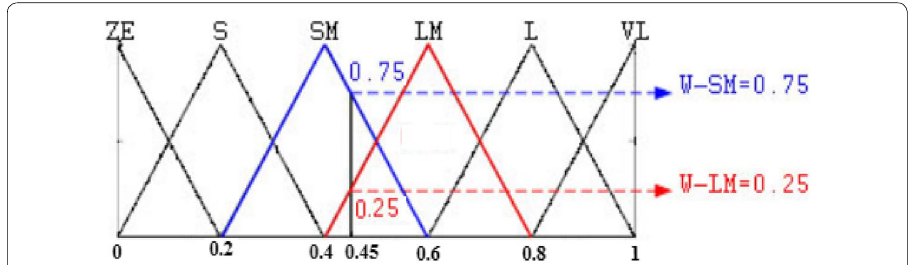
Fig. 6 Input membership of the variables λ or μ